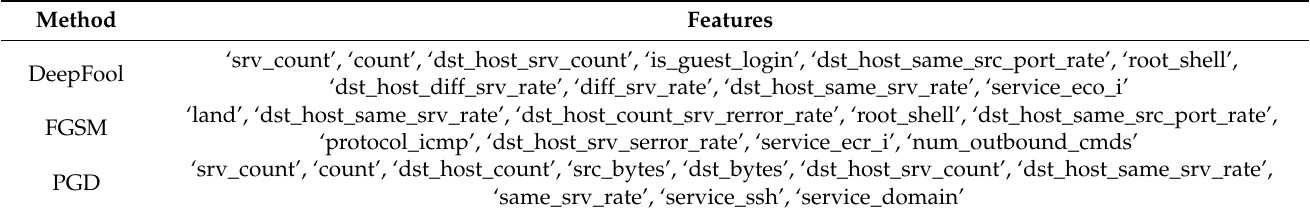
Table 6. Feature participation top ten in adversarial example generation.